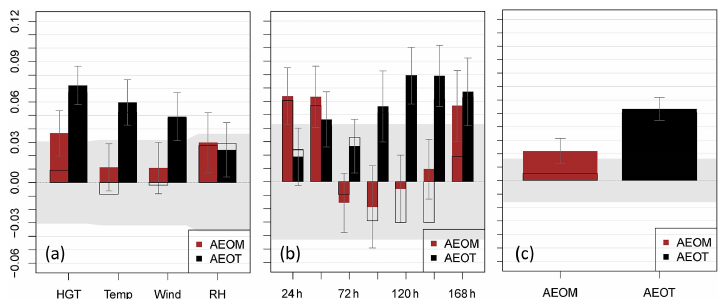
Figure 16. The summary assessment metric (SAM) overall forecast scores for AEOM and AEOT versus BASE experiments in the North American (NA) region for day 1–7 forecasts validated at 00:00UTC 22–28 November 2019. The scores are shown for (a) forecast parameters of temperature (Temp), geopotential height (HGT), vector wind (Wind), relative humidity (RH), (b) lead times, and (c) the overall perfor- mance of AEOM and AEOT. The forecasts are verified to their self-analyses. Values above 0.0 demonstrate an increase in the mean of the normalized distribution and improvement of the forecast versus the BASE, while the shaded region represents the 95% significance level. The gray areas indicate the 95% confidence level under the null hypothesis that there is no difference between experiments for this metric. In addition, the estimated uncertainty at the 95% level is indicated by small error bars at the ends of the color bars. In total, two normalizations are used, i.e., the ECDF (colors) and rescaled min/max normalization (black outline). Details can be found in Hoffman et al. (2018). A value of 0.02, for example, indicates the average normalized statistic over all statistics is better (greater) by 0.02 than BASE. Under the null hy- pothesis that there are no differences, all SAMs would be one-half, so a 0.02 improvement can be considered a 4% improvement (0 . 02 / 0 . 5) in normalized scores.